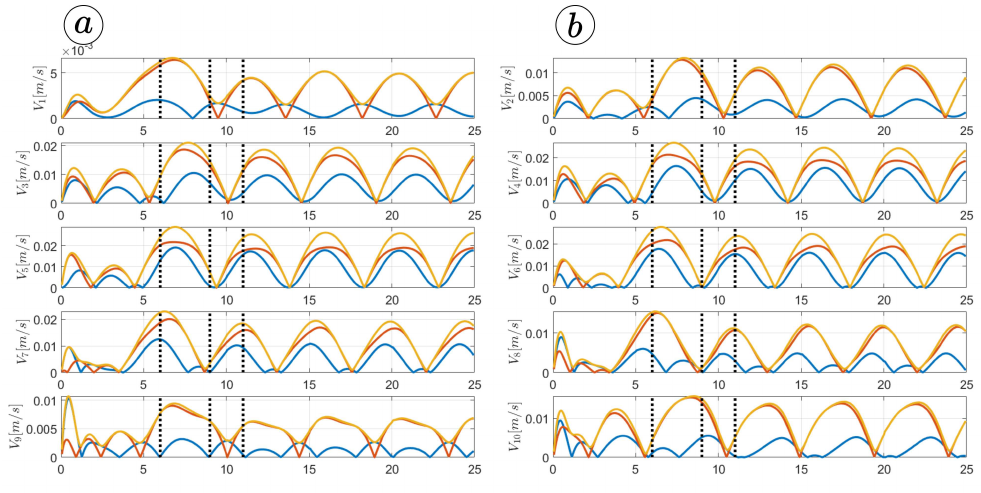
Figure 15. Velocities of the snake robot’s segments for c t = 10 ( a ) and c n = 10 ( b ).